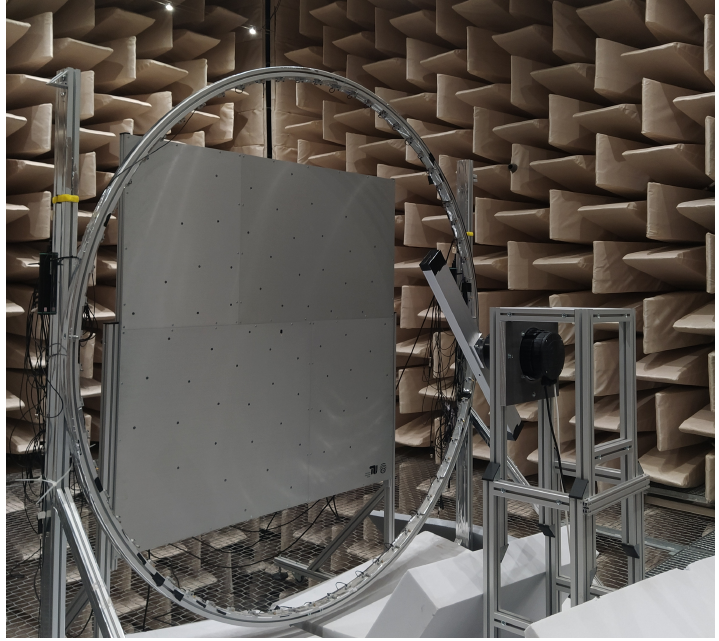
Figure 3. Photograph of the measurement setup in the anechoic chamber at TU Berlin.